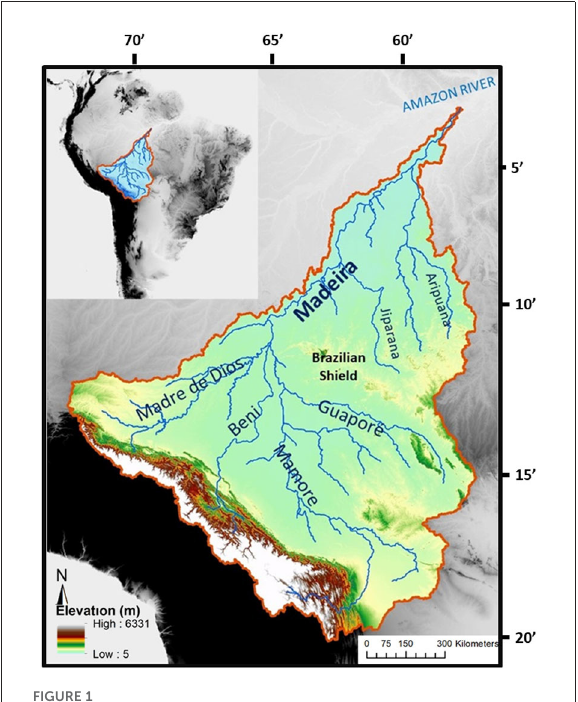
FIGURE1 Location of the Madeira Basin (South America) and its main tributaries (blue lines) and topography